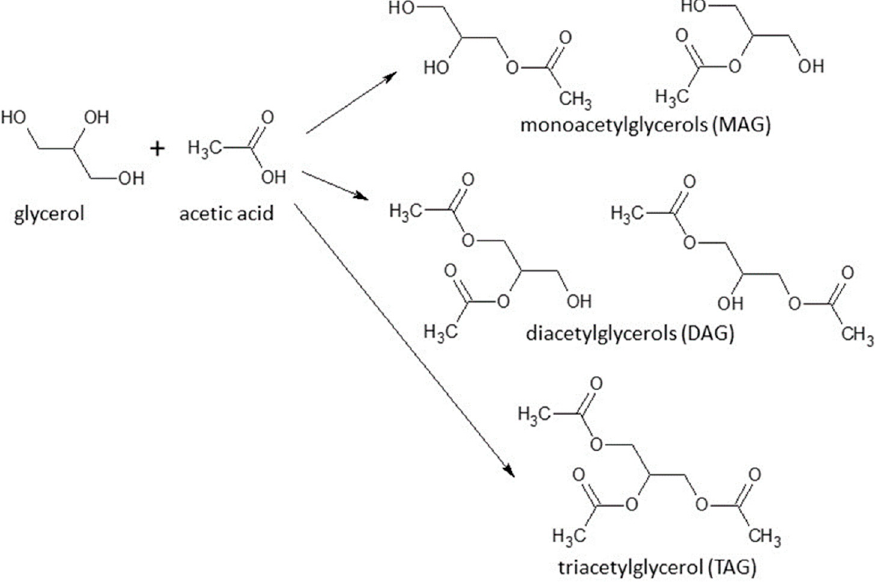
Figure 26. Esterification of acidic acid with glycerol. Reproduced with permission from ref. [192] Copyright © 2011 Elsevier.